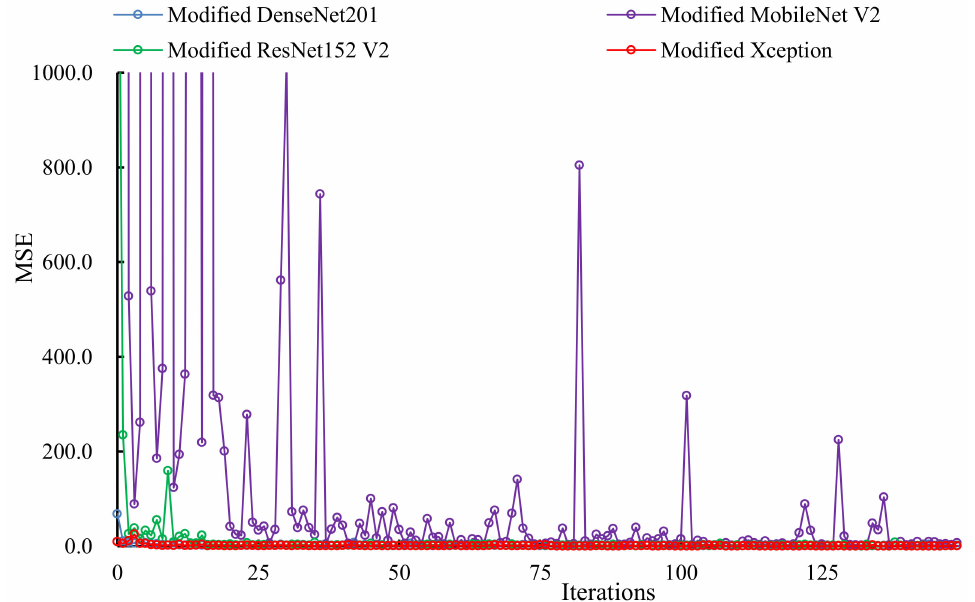
Figure 7. Loss change on validation set of each